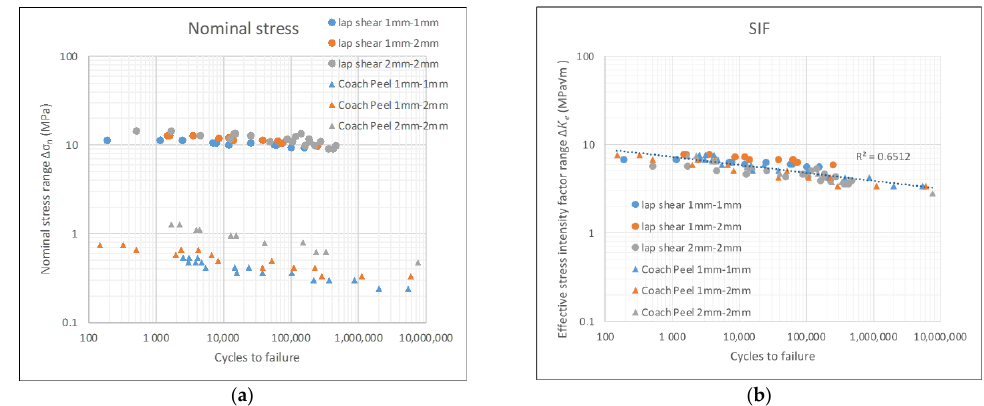
Figure 13. The test data correlation for both the coach-peel and lap-shear specimens. ( a ) Nominal stress range. ( b ) Effective stress intensity factor range.